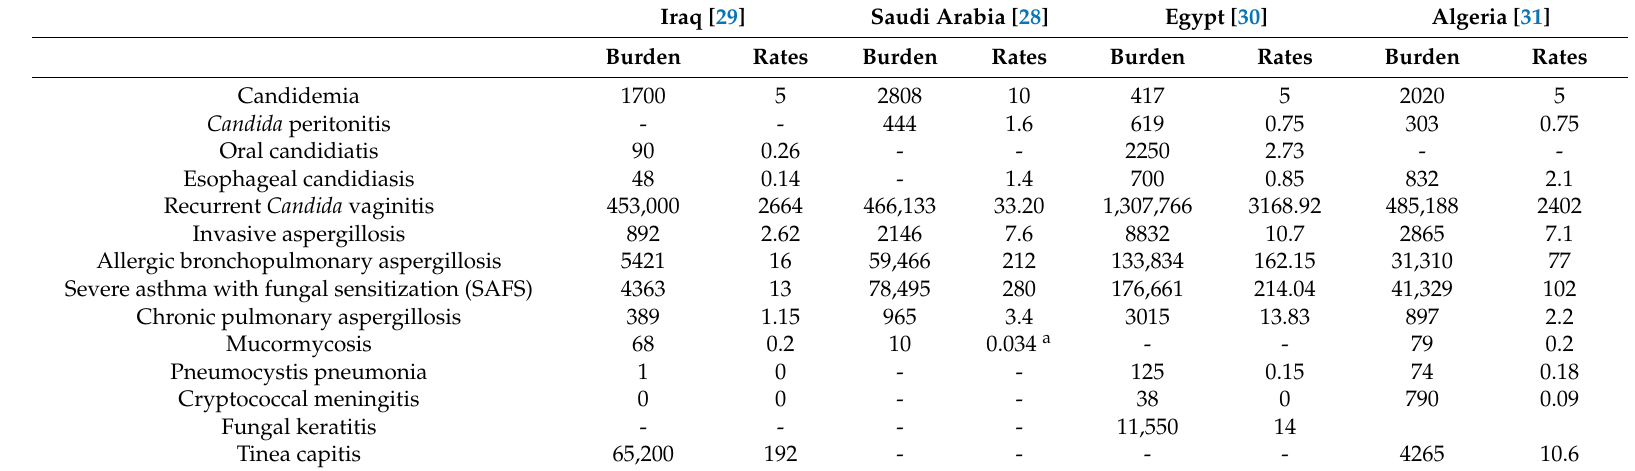
Table 2. The burden of serious fungal infections in selected Arab countries located in Southwest Asia and North